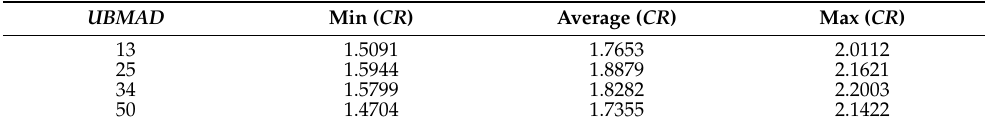
Table 6. Dependence of the minimum, maximum, and average values of CR on UBMAD for the case of DAT2 of depth 4.